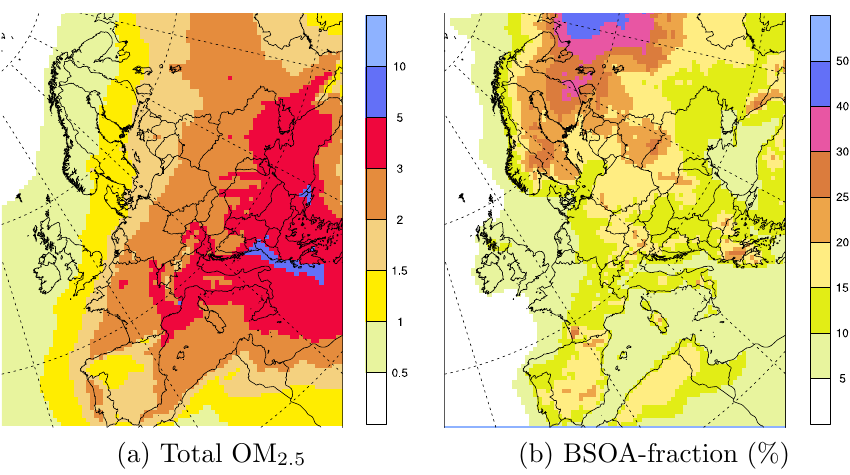
Figure 3. Model calculated 6-month mean (Apr–Sep) concentrations of (a) total Organic Matter in PM 2 . 5 (OM 2 . 5 ) (Unit: µgm − 3 ). (b) Fraction of biogenic secondary organic aerosol (BSOA) (% of total OM 2 . 5 ) for the reference scenario without explicit biotic stress emissions (Case